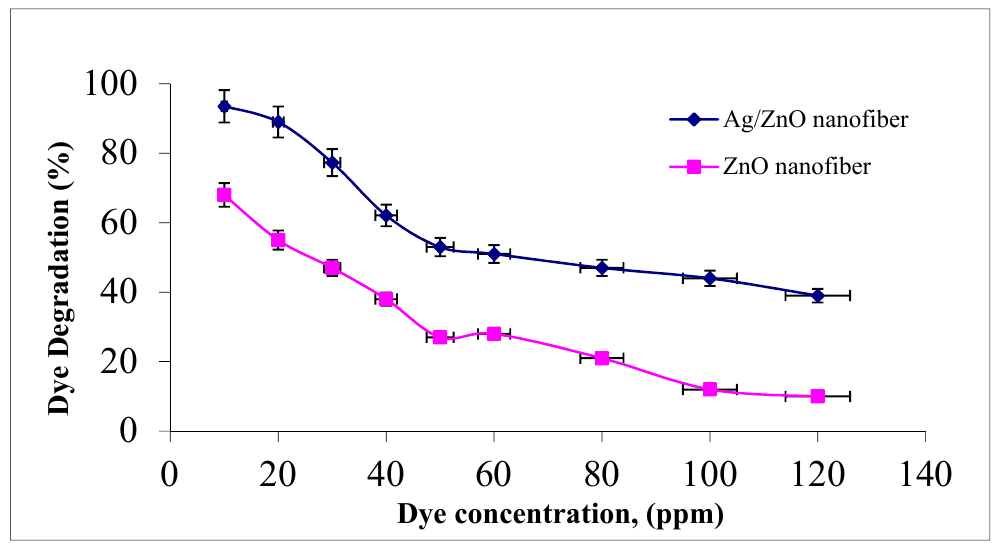
Figure 7. Effect of initial MG dye concentration on MG dye photocatalytic degradation process using ZnO polymeric nanofiber after and before silver immobilization (contact time = 60 min, nanofiber dose = 0.1 g, pH = 7 at room temperature).